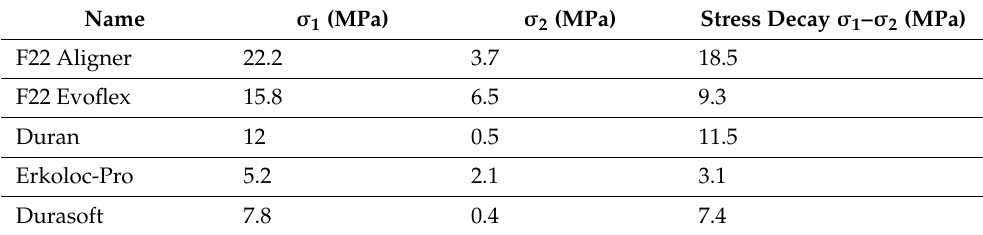
Table 3. Mean initial stress, final stress and stress decay (means).